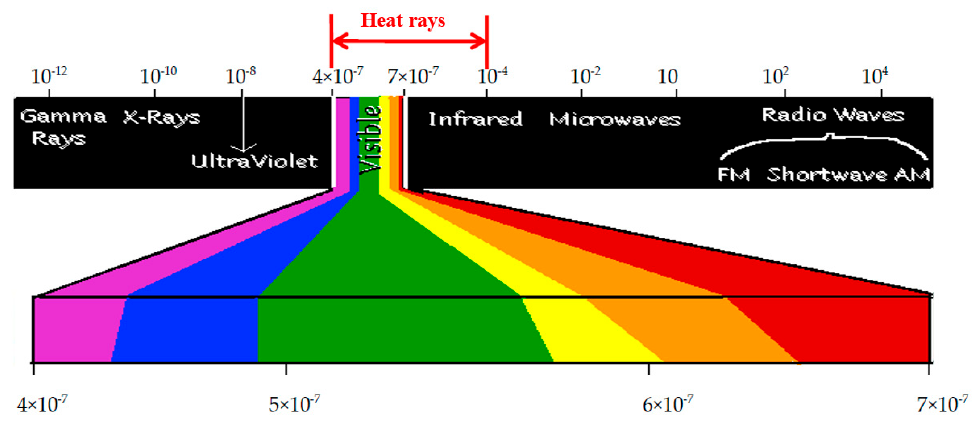
Figure 2. Solar heat ray emission spectrum.